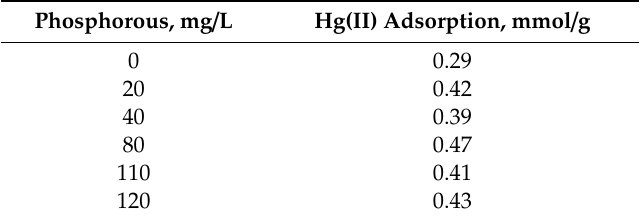
Table 2. E ff ect of phosphorous concentration in the medium on Hg(II) adsorption. Phosphorous, mg /